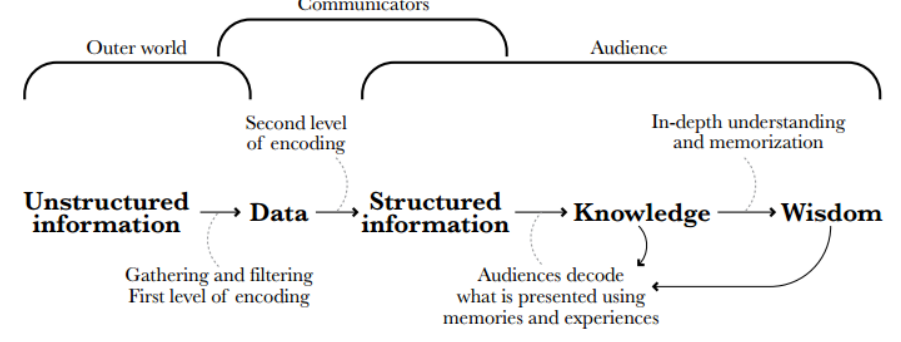
Figure 1. Data-Information-Knowledge-Wisdom